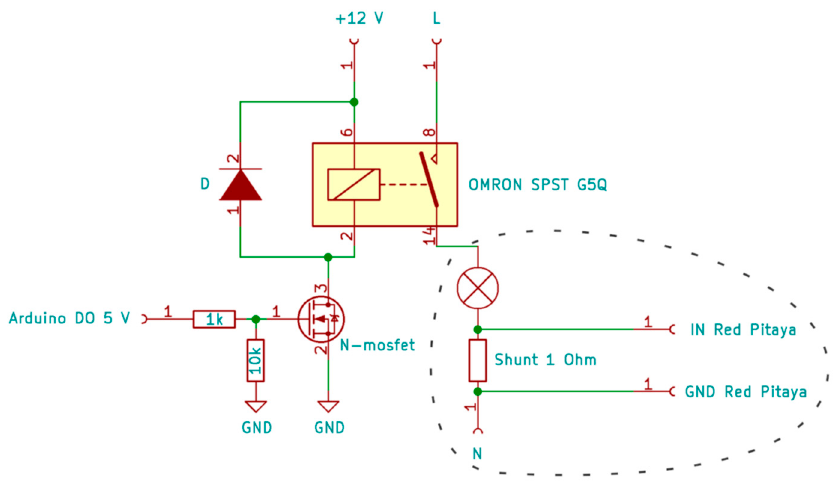
Figure 15. Electric circuit diagram for measuring the electric current through a light bulb (circled area).